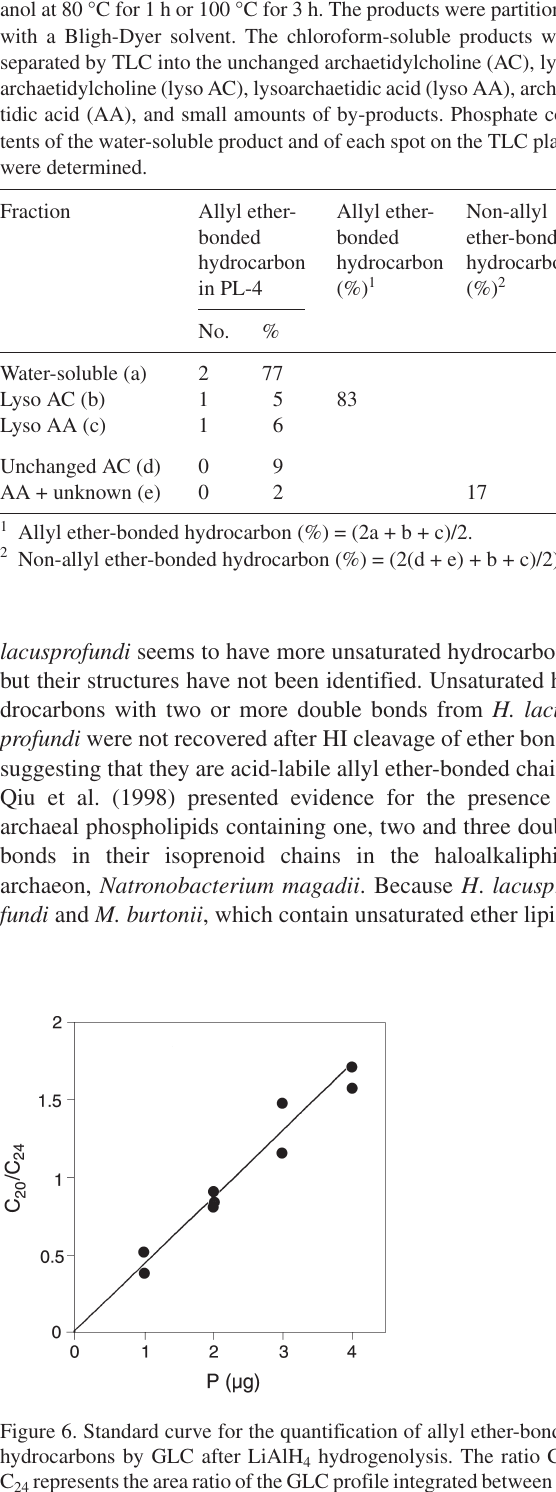
Table 2. Composition of hydrocarbon chains of PL-4. Allyl ether-